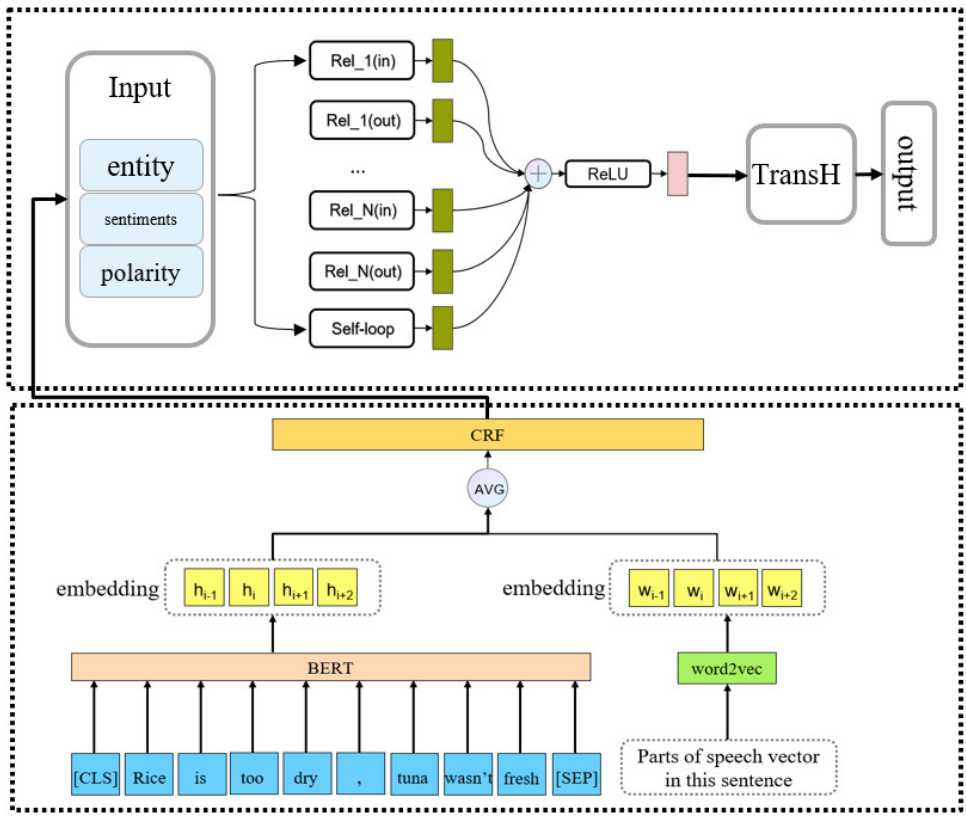
Figure 1. Overall structure of